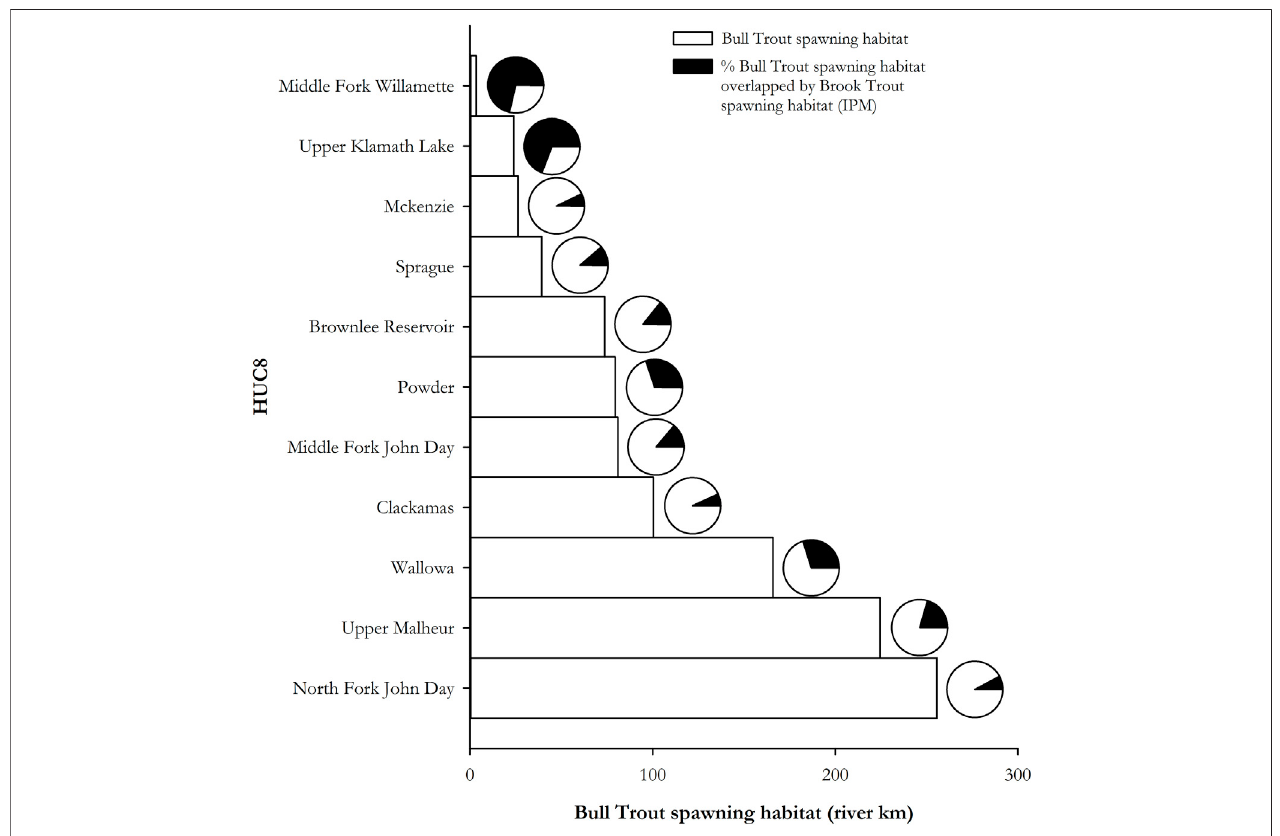
FIGURE 7 | Brook trout spawning habitat intrinsic potential and overlap with bull trout spawning habitat at the HUC8 sub-basin level.